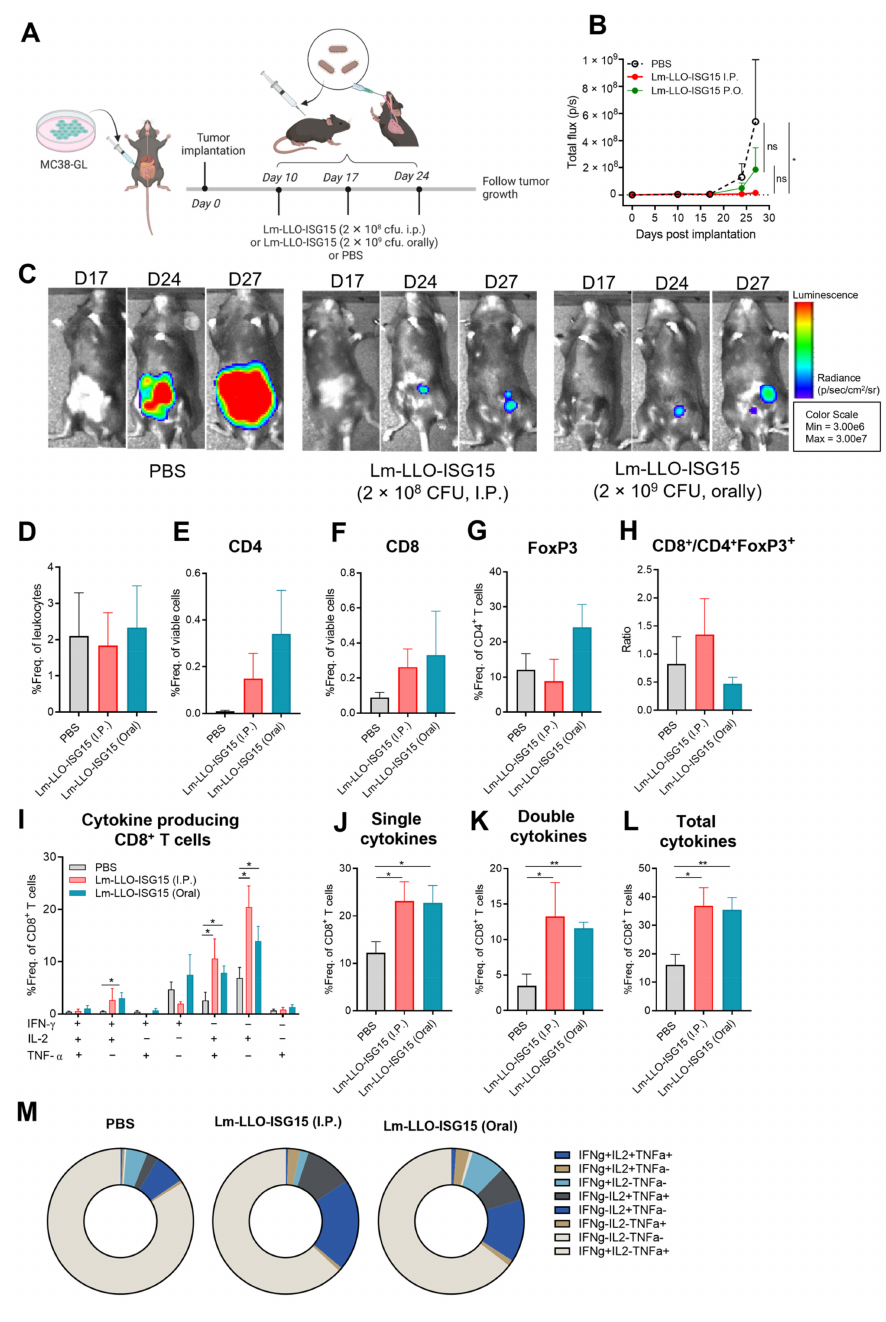
Figure 4. Efficacy of Lm-LLO-ISG15 i.p. versus p.o in orthotopic CRC mouse